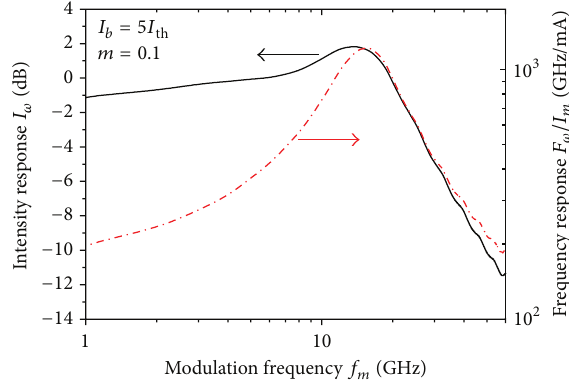
Figure 1: The intensity and frequency modulation responses of the and 𝑚 = 0.1 solitary laser when 𝐼 𝑏 = 5𝐼 th